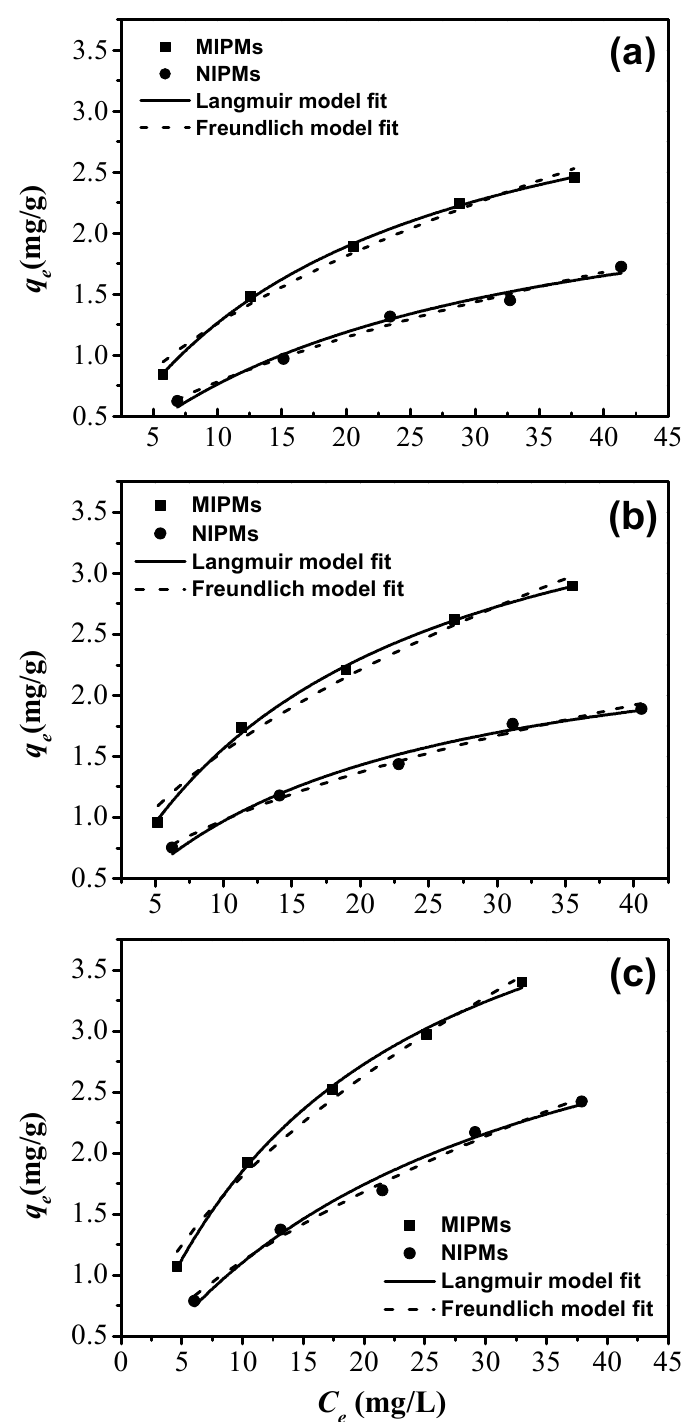
Figure 8. ( a – c ) Isothermal analysis for the enrichments of clenbuterol onto the NIPMs and MIPMs at 30 °C ( a ), 45 °C ( b ), 60 °C ( c ).